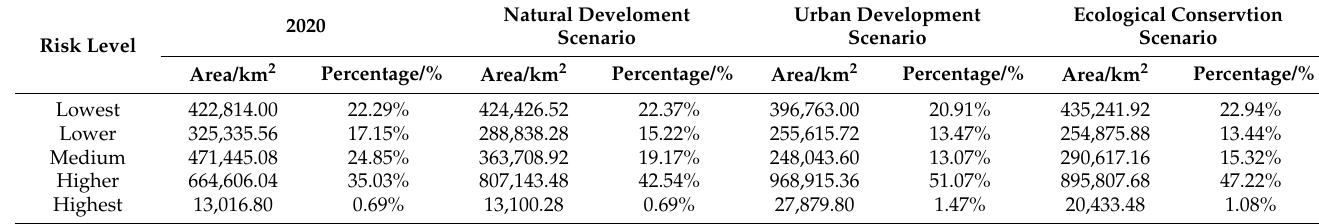
Table 4. Comparison of the area of each class of landscape ecological risk in Xinjiang in 2020 and 2030 under different scenarios.